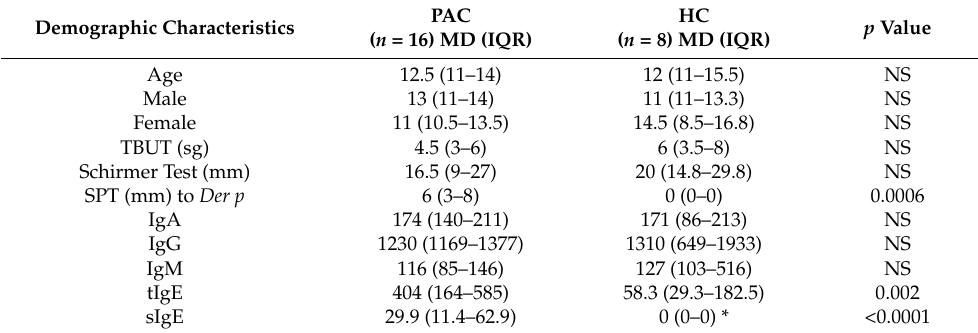
Table 1. Demographics characteristics of patients with PAC and healthy